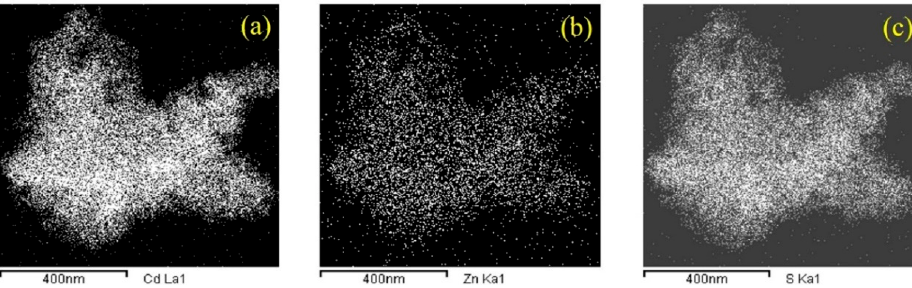
Figure 6. HAADF images of Zn 0.1 Cd 0.9 S solid solution: ( a ) Zn atomic distribution; ( b ) Cd atomic distribution and ( c ) S atomic distribution.